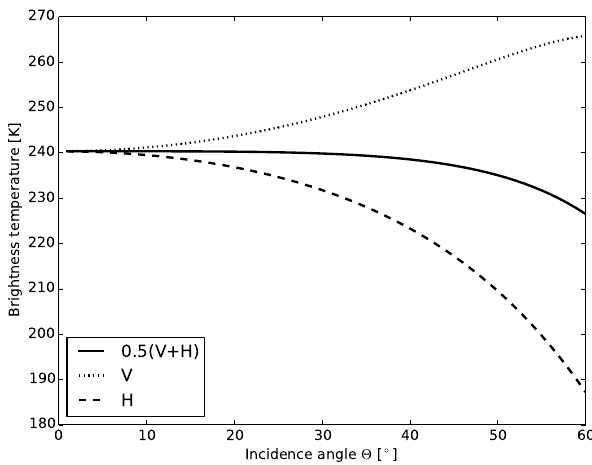
Figure 3. Vertically (V) and horizontally (H) polarized TBs and the first Stokes parameter as a function of incidence angle calculated using a three-layer model for sea ice with a thickness of d ice = 1m, a bulk salinity of S ice = 8 gkg − 1 , and a bulk ice temperature of T ice = − 7 ◦